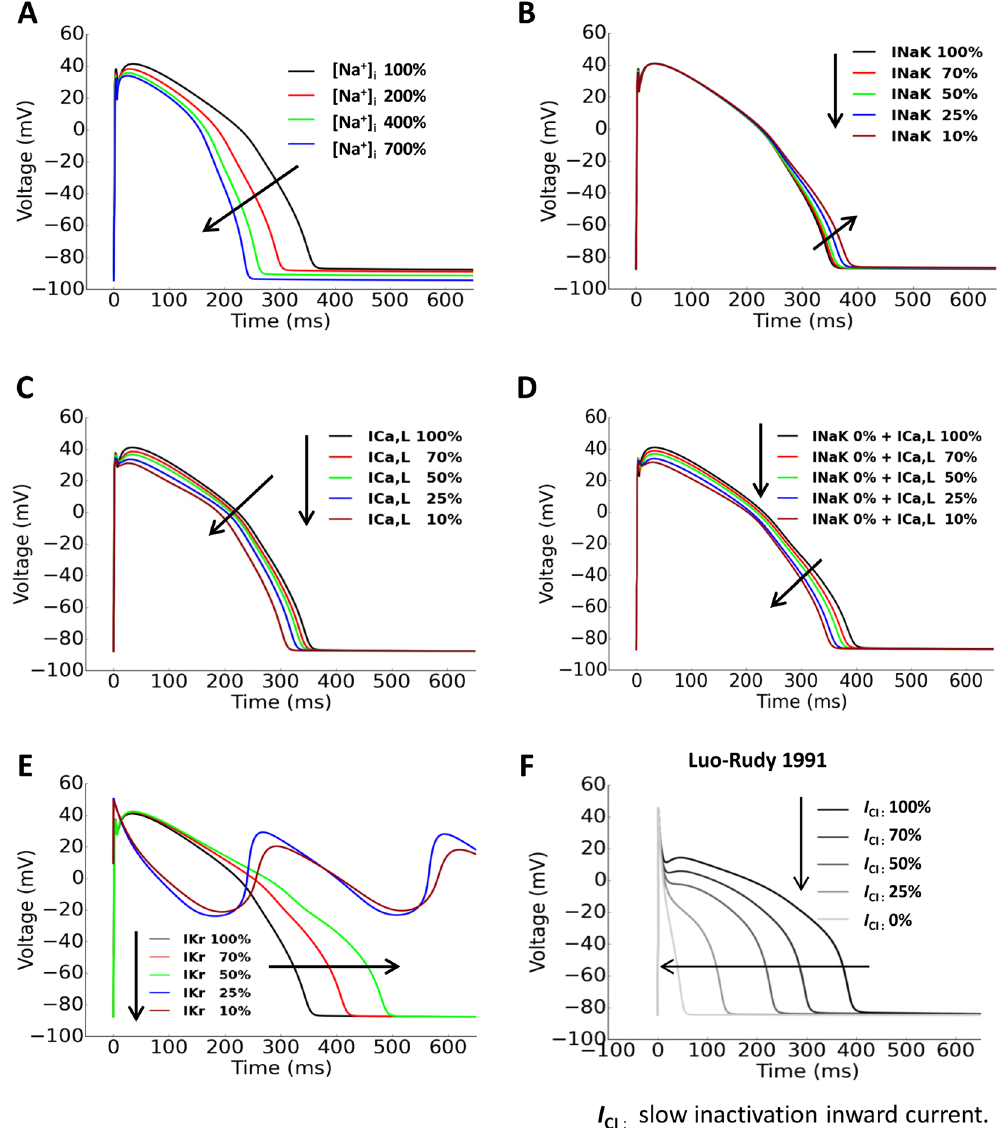
Figure 8. Simulated effects of reduced I NaK , I Ca,L and I Kr on ventricular APs. ORd model was adopted in A~E. ( A ) Simulated effect of increased [Na + ] i on APs. ( B ) Simulated effect of reduced I NaK alone on APs. ( C ) Simulated effect of reduced I Ca,L alone on APs. ( D ) Simulated effects of I NaK (0%) in combination with reduced I Ca,L on APs. ( E ) Simulated effect of reduced I Kr on APs. ( F ) The effect of reduced I Ca,L on APs simulated by the LRd